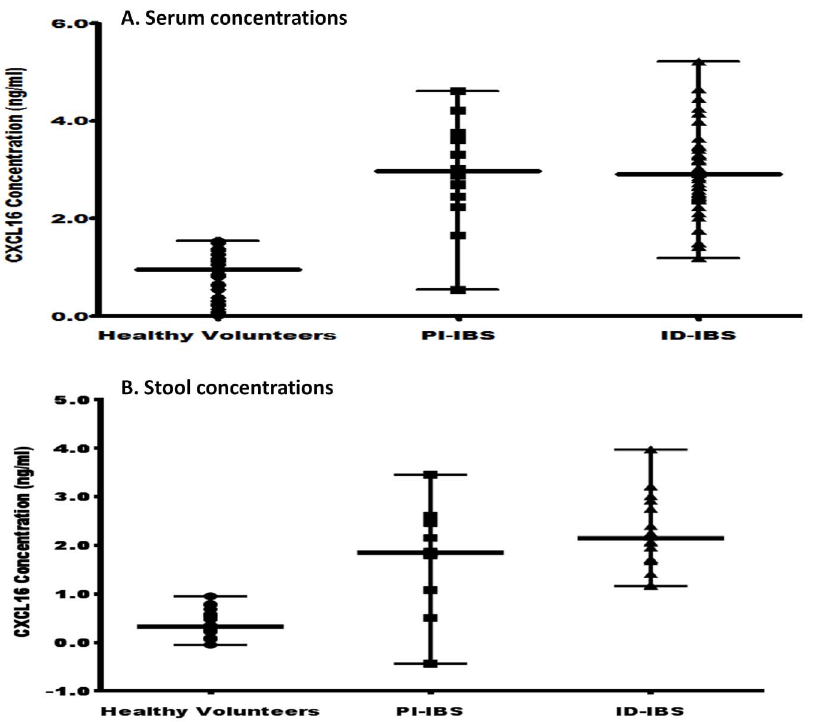
Figure 6. The sera and stools of IBS patients indicate higher levels of the chemokine CXCL16 than that of healthy volunteers. Sera and stools from IBS patients and healthy volunteers were evaluated for CXCL16 concentration using quantitative ELISA (R&D Systems, Minneapolis, MN). Mann Whitney test showed significant difference between the medians of the healthy volunteers versus ID-IBS (P , 0.0001) and PI-IBS (P , 0.0001). The medians of ID-IBS versus PI-IBS were not significantly different (P=0.6219). Error bars indicate median values with